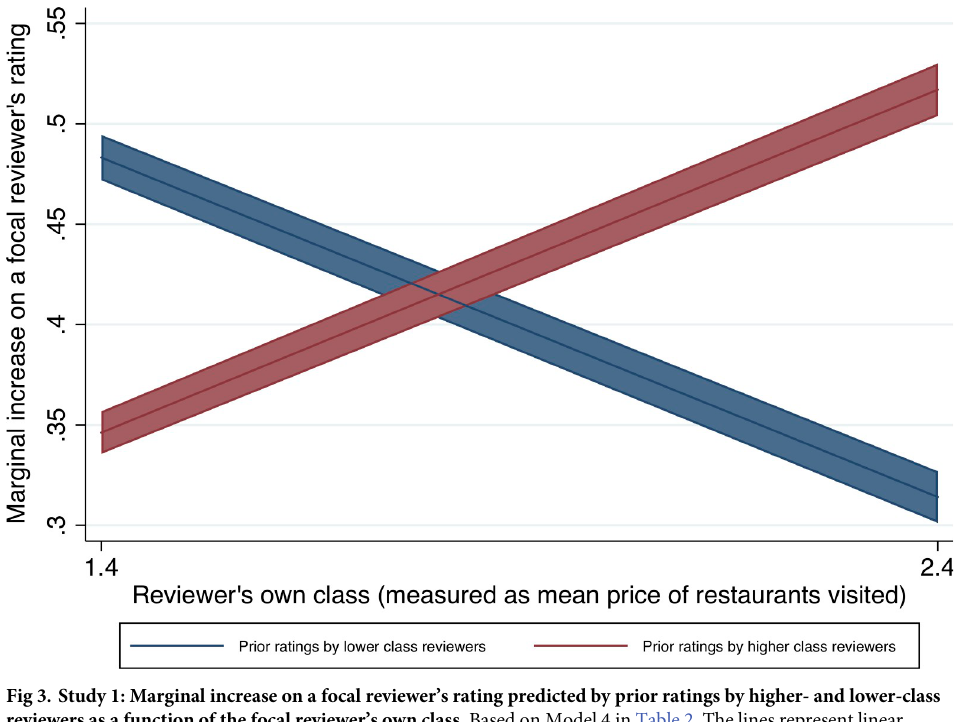
Fig 3. Study 1: Marginal increase on a focal reviewer’s rating predicted by prior ratings by higher- and lower-class reviewers as a function of the focal reviewer’s own class. Based on Model 4 in Table 2. The lines represent linear regression estimates, the shaded areas show the 95% confidence